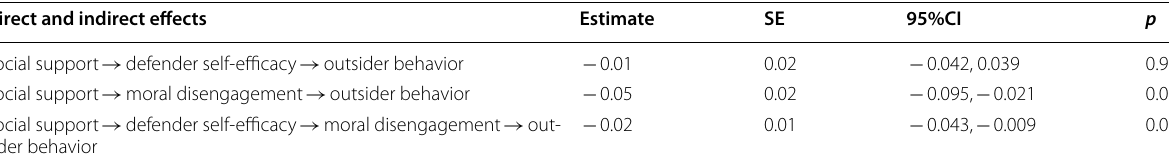
Table 4 Summary of the direct and indirect effects Direct and indirect